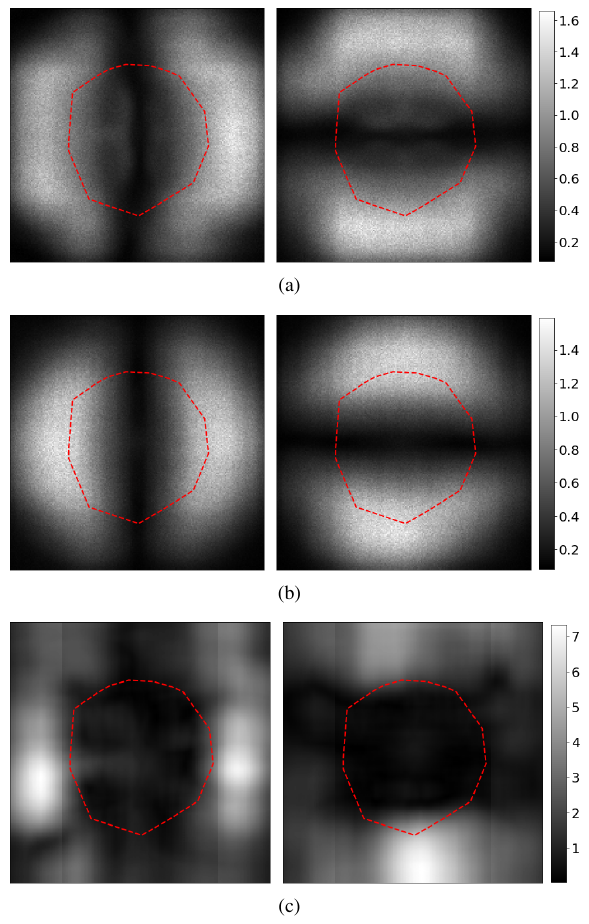
Figure 5. Epistemic standard deviation on column (left) and row (right) direction on the evaluation grid dataset in pixel units with (a) MCDO (Gal and Ghahramani, 2016) , (b) MCDONLL (Kendall and Gal, 2017), and (c) Ensemble (Lakshminarayanan et al., 2017) in case of case of prior probability shift (case 1) and interpolation. The models are trained on the prior probability shift dataset. The red dotted polygon represents the convex hull of the square center positions of the training dataset.